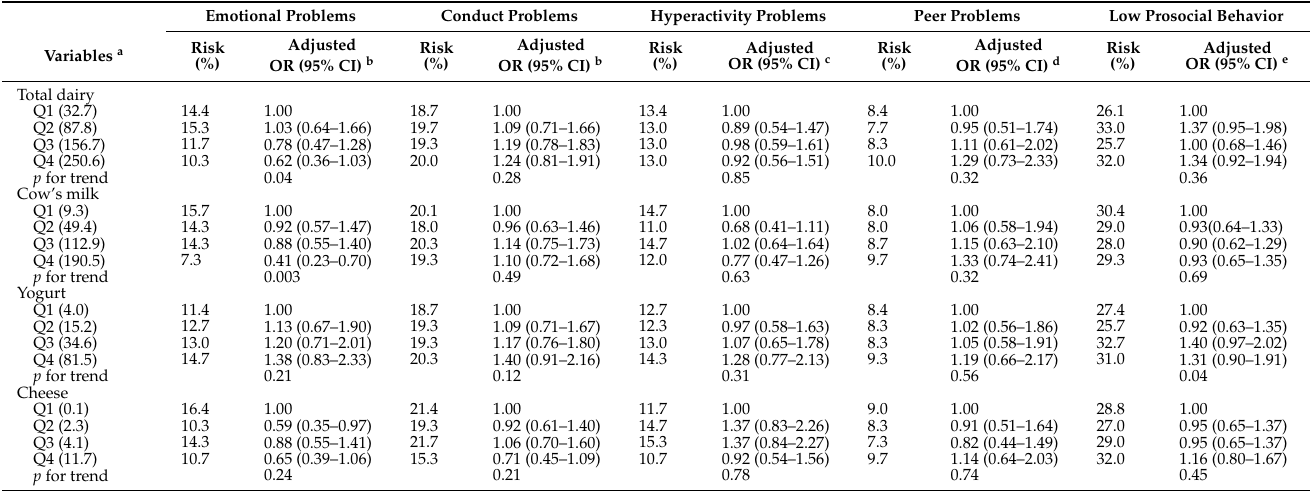
Table 2. Odds ratios (ORs) and 95% confidence intervals (CIs) for behavioral problems assessed by the Strength and Difficulties Questionnaire in 1199 5-year-old children by quartiles of maternal dairy product intake during